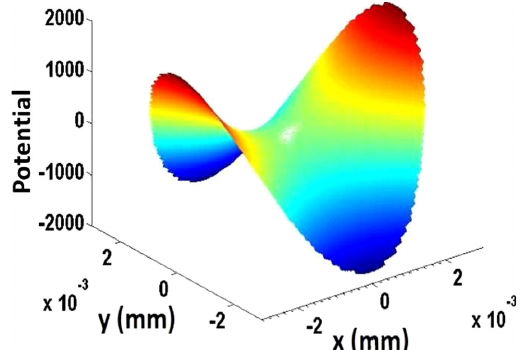
FIG. 14. RFQ potential at a given longitudinal position and at a given time. The potential is saddle-shaped, explaining the behavior seen in Fig.